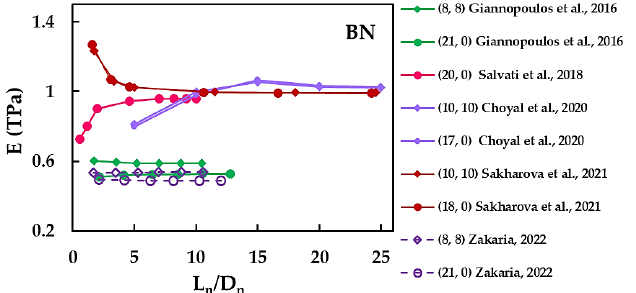
Figure 4. Young’s modulus, E, of BNNTs as a function of the nanotube aspect ratio, L n / D n [31,36,65,68,69]. The E evolutions as a function of L n / D n reported by Sakharova et al. [36] for (10, 10) and (18, 0) BNNTs are in satisfactory agreement with those obtained by Choyal et al. [31] for (10, 10) and (17, 0) BNNTs and by Salvati et al. [65] for (20, 0) BNNT, in case of nano- tube aspect ratios L n / D n > 8. Zakaria [68] and Giannopoulos et al. [69], in their numerical simulation studies within NCM/MSM approach, obtained for (8, 8) and (21, 0) BNNTs